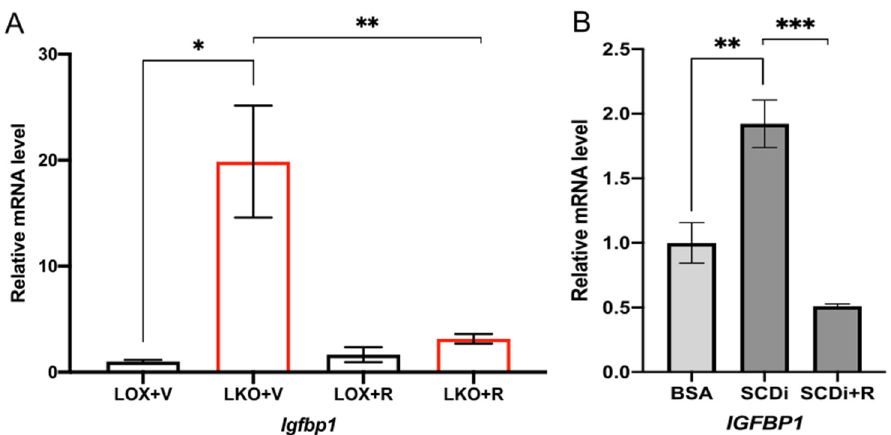
Figure 3. Inhibition of mTORC1 by rapamycin suppresses IGFBP1 induction. ( A ) Relative hepatic Igfbp1 mRNA levels in 10–12 weeks old male LOX and LKO mice fed HCD diet for 10 days treated daily with either vehicle (n = 3 LOX; 3 LKO) or rapamycin (n = 5 LOX + R; 5 LKO + R). ( B ) Relative Igfbp1 mRNA levels of HepG2 cells treated with either BSA (n = 5), BSA plus 1 μ M SCD inhibitor (n = 5), or BSA plus 4 μ M SCD inhibitor and rapamycin (n = 5). Values are mean ± SEM; * p < 0.05 vs. LOX or BSA; ** p < 0.01 vs. LOX+V or BSA; *** p < 0.005 vs. LOX or BSA by Student ′ s two-tailed t -test.